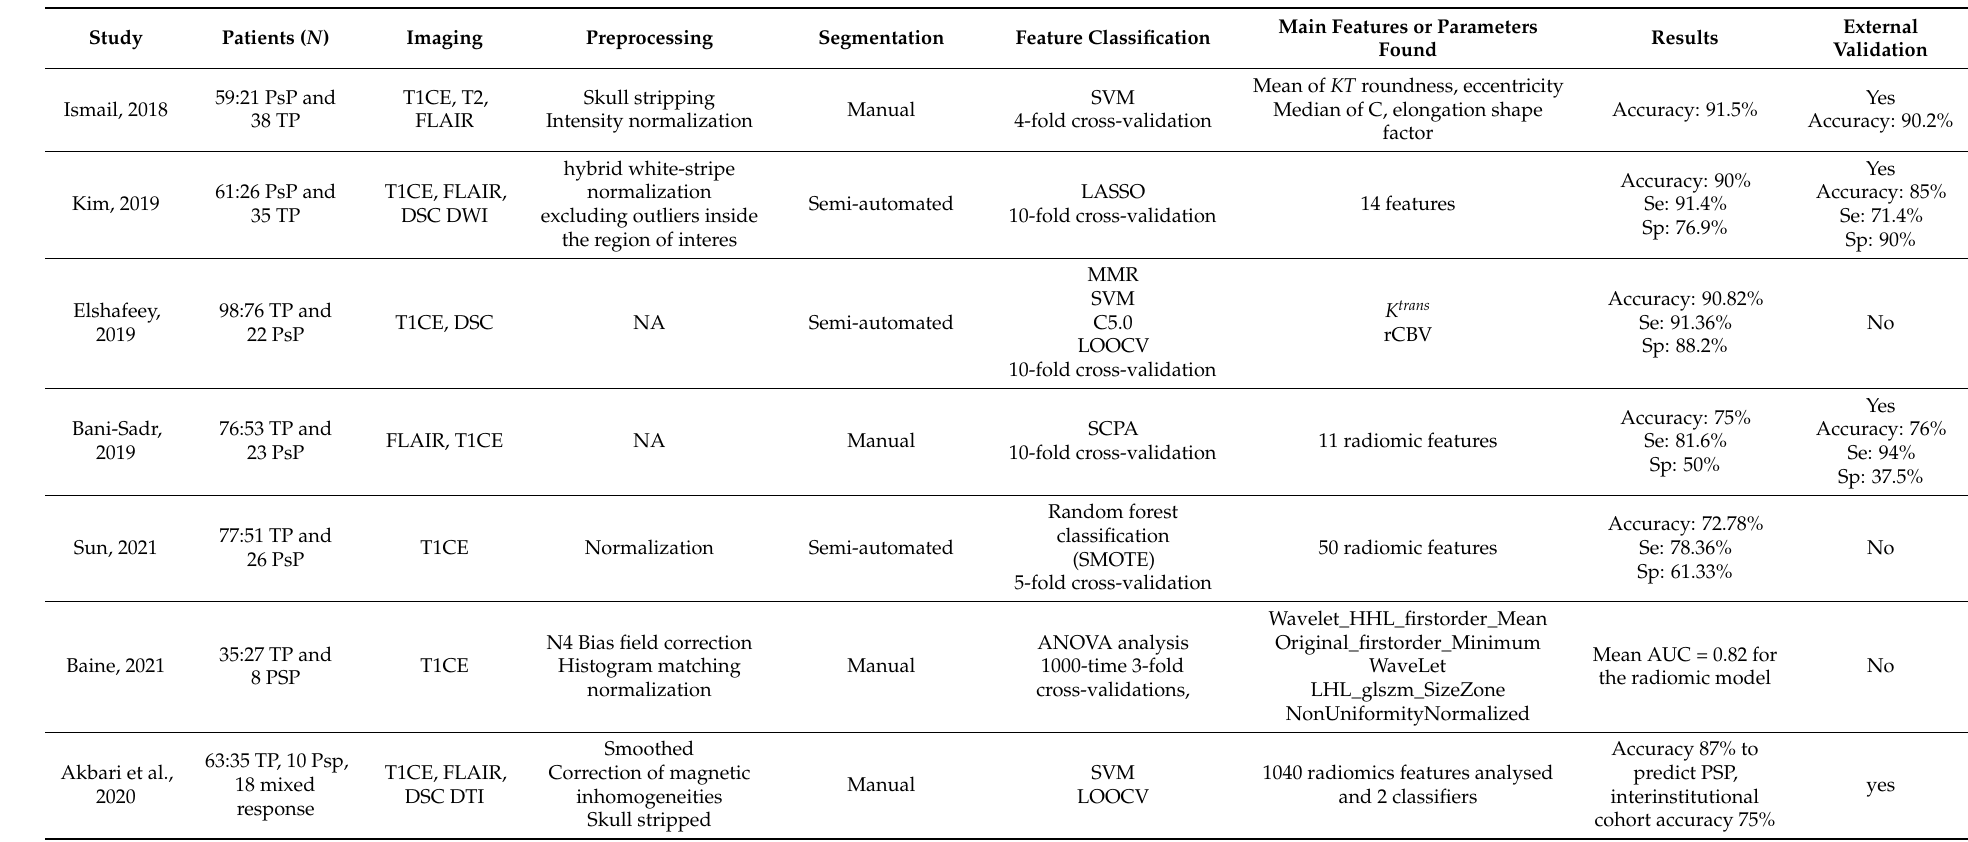
Table 4. Studies that evaluated the use of radiomics models to differentiate between PsP and TP. Abbreviations: C: curvedness; Gd: gadolinium; KT : measure of total curvature; PsP: pseudoprogression; RANO: Response Assessment in Neuro-Oncology; S: sharpness; SI: shape index; SVM: support vector machine; TP: tumor progression; LOOCV: leave-one-out cross-validation; NA: not available; LASSO: least absolute shrinkage and selection operator; SMOTE: synthetic minority oversampling technique; SPCA: supervised principal component analysis; MMR = maximum relevance minimum redundancy. N = number of patients; Se: sensitivity; Sp: specificity. TP = true progression, PsP = pseudoprogression, DWI = diffusion-weighted imaging, DSC = dynamic susceptibility contrast, T1CE = T1